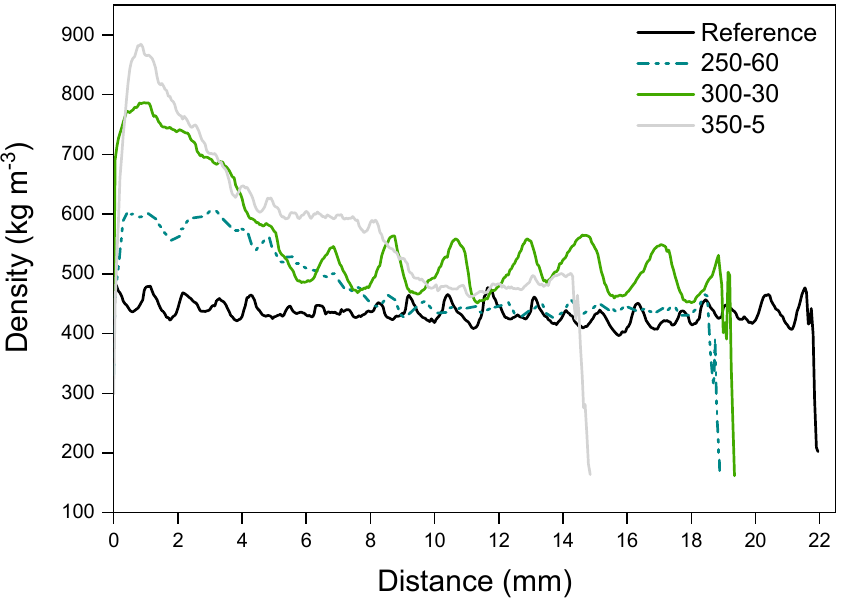
Figure 7. Density (kg m − 3 ) of charred samples measured at the distance of 0–22 mm from the charred surface. The figure including standard deviations is presented in Supplementary Figure S2.